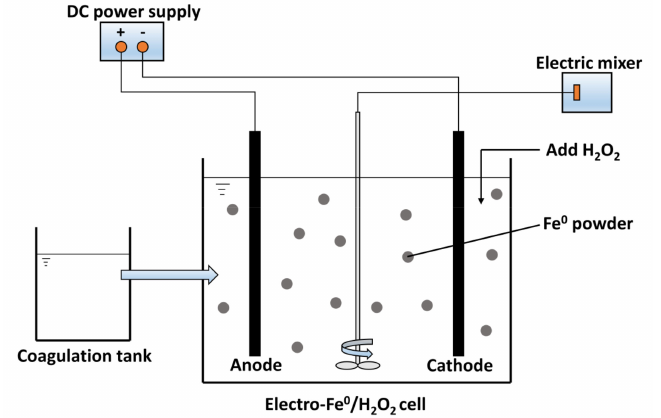
Figure 1. The experimental device of coagulation combined with the electro-Fe 0 /H 2 O 2